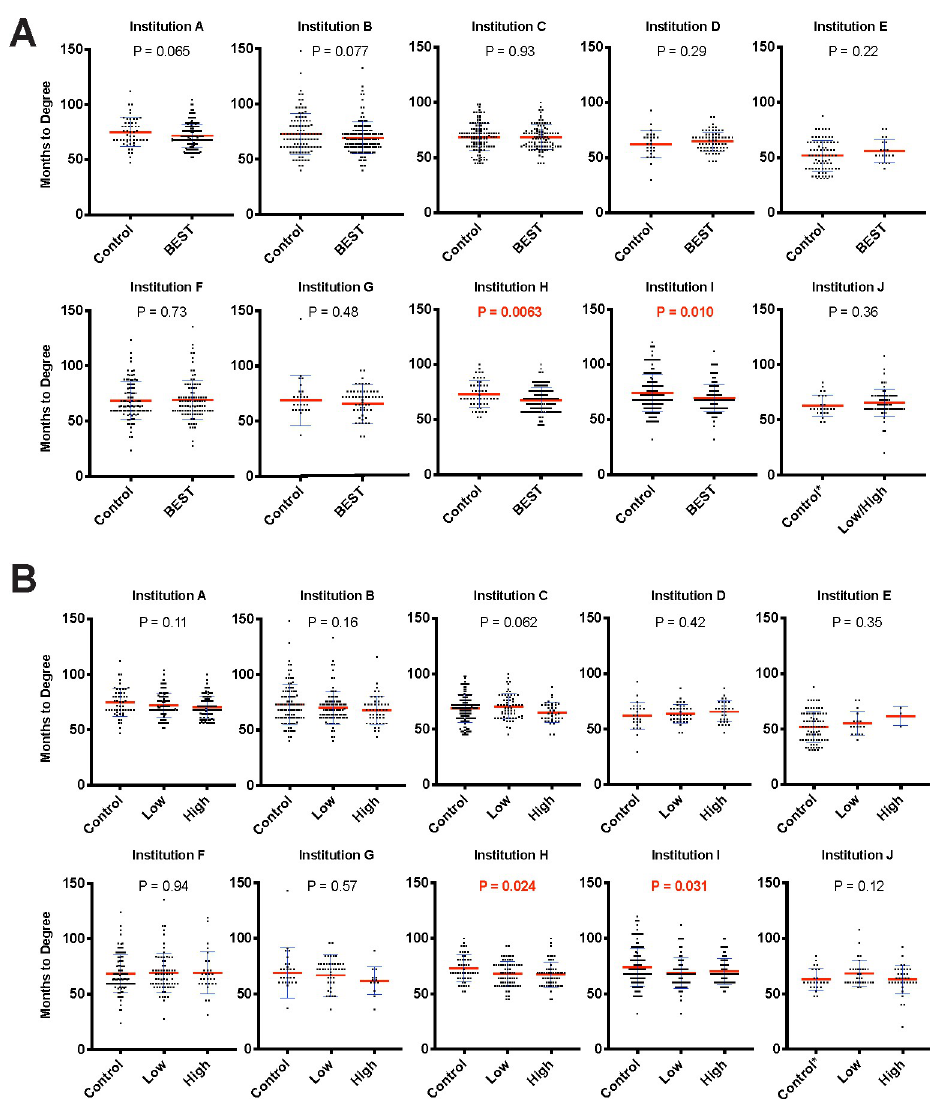
Fig 1. Professional development participation is not associated with an increase in time to degree. (A) Months to degree vs. binary professional development participation. Blue error bars represent standard deviation of the mean. Mean is denoted by a red line. Independent samples t tests (see Table F in S1 Text for statistical test results) were used to compare control (nonparticipants) vs. participant time to degree (significant values of p < 0.05 noted in red). Control � for institution J indicates that the control individuals were approximated based on available participation data (see Material and methods). (B) Months to degree vs. dosage of professional development participation. Blue error bars represent standard deviation of the mean. Mean is denoted by a red line. ANOVA was used to compare the impact of control, low-, and high-dose participation on time to degree (significant values of p < 0.05 noted in red). Control � for institution J indicates that the control individuals were approximated based on participation data (see Material and methods). The remaining participants were divided into low- and high-participation groups. All data sets are available at https://osf.io/qy3pa/ (permanent DOI: 10.17605/OSF.IO/QY3PA; see also [33]). ANOVA AU : AbbreviationlistshavebeencompiledforthoseusedinFigs 1 (cid:0) 6 : Pleaseverifythatallentriesarecorrect : , analysis of variance; BEST, Broadening Experiences in Scientific